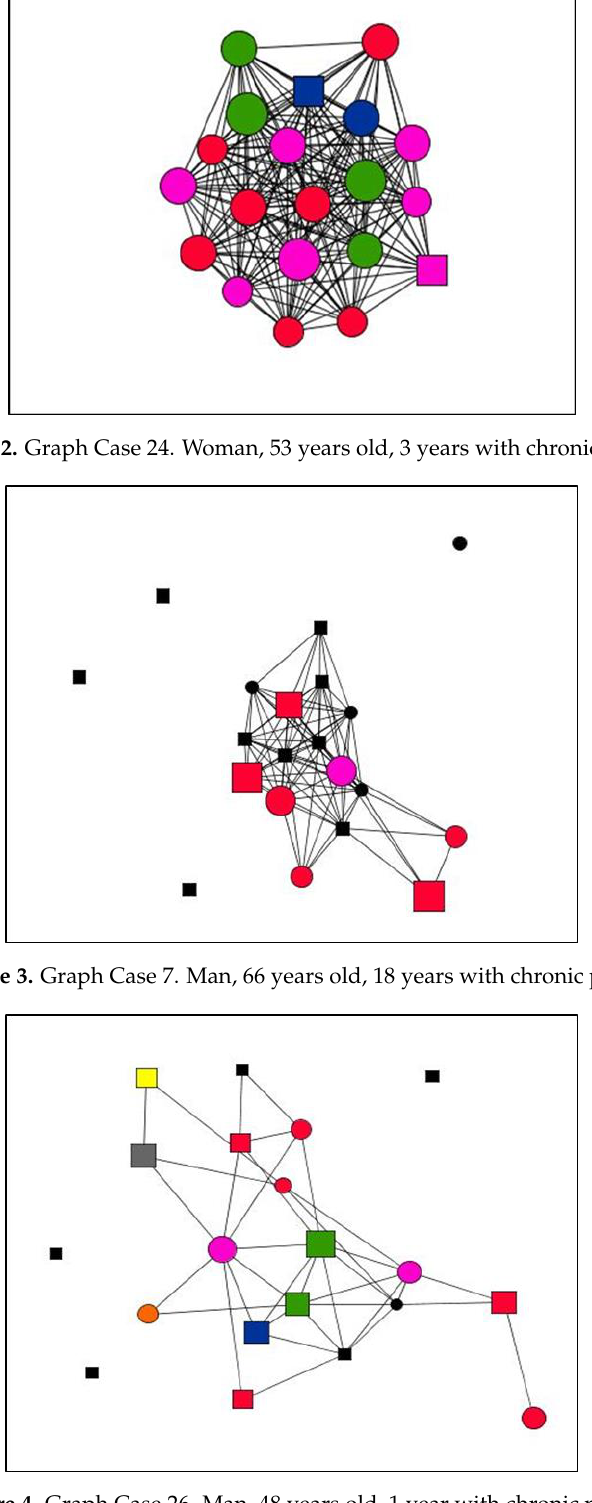
Table 5. Descriptive analysis of social support at ego level.